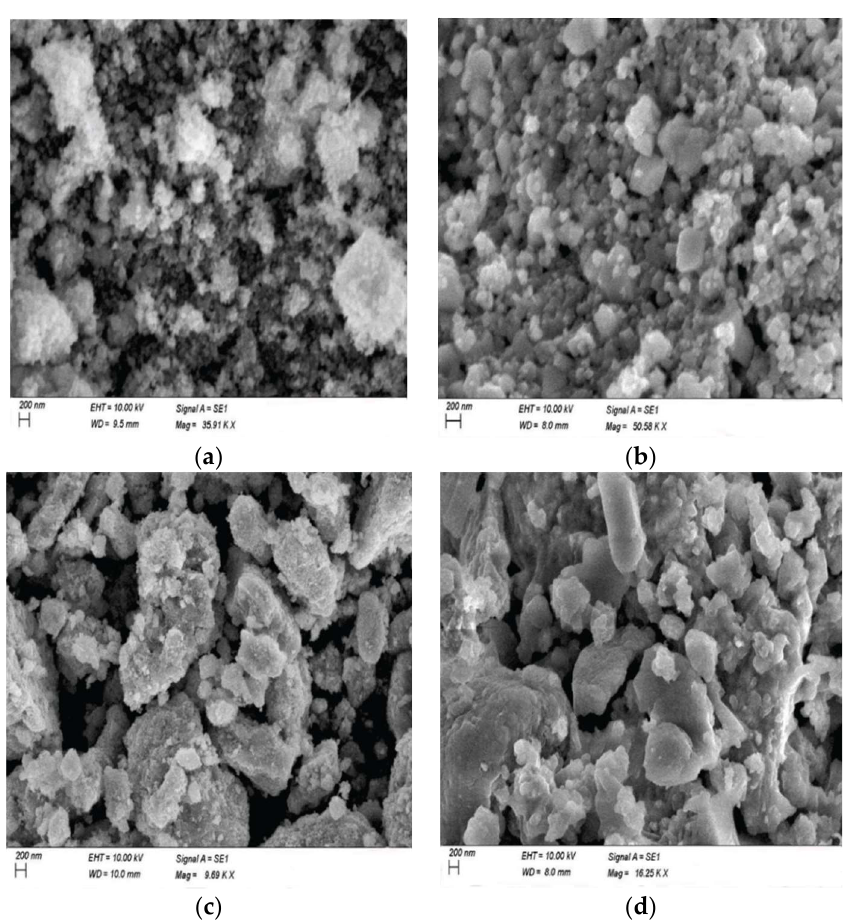
Figure 2. SEM images of Fe 3 O 4 nanoparticles ( a ), CuFe 2 O 4 nanoparticles ( b ), Fe 3 O 4 nanoparti- cle-immobilized laccase ( c ), and CuFe 2 O 4 nanoparticle-immobilized laccase ( d